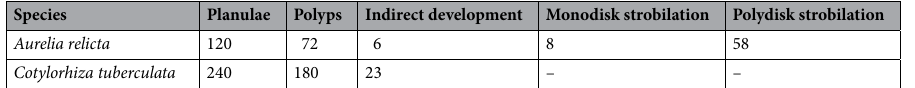
Species Table 1. The number of planulae collected from adult scyphomedusae, full-grown polyps, indirect developments, mono- and polydisk strobilations observed in Aurelia relicta from Mljet (Croatia) in 2004 and Cotylorhiza tuberculata from the bay of Pozzuoli (southern Italy) in 2019.